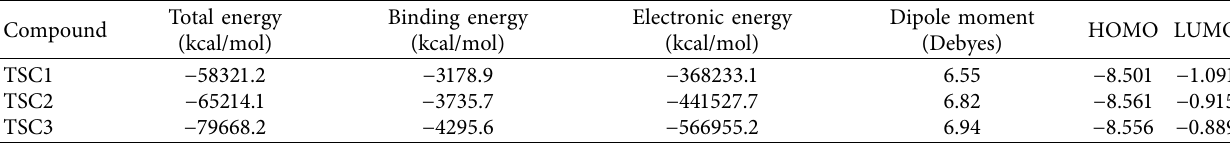
Figure 3: Expansion of the intermolecular interactions (i.e., van der Waals interaction) between the TSC2 molecules. Table 1: Some energetic properties of the synthesized thiosemicarbazone compounds.